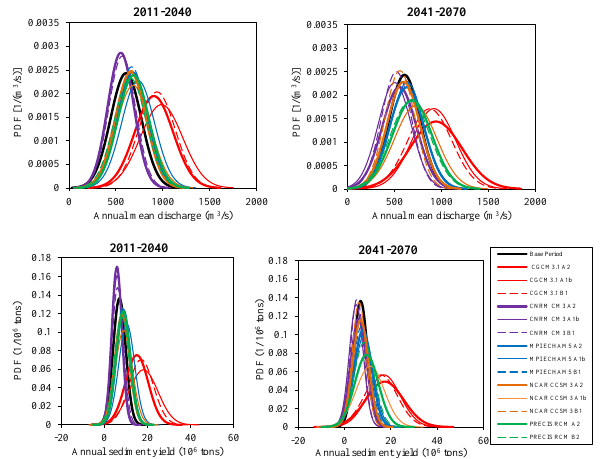
Fig. 16. Probability density functions of annual mean discharge and annual sediment yield data for all climate projections, and for the 1971–2000 as base period. PDFs are presented for the 2011–2040 and 2041–2070 time